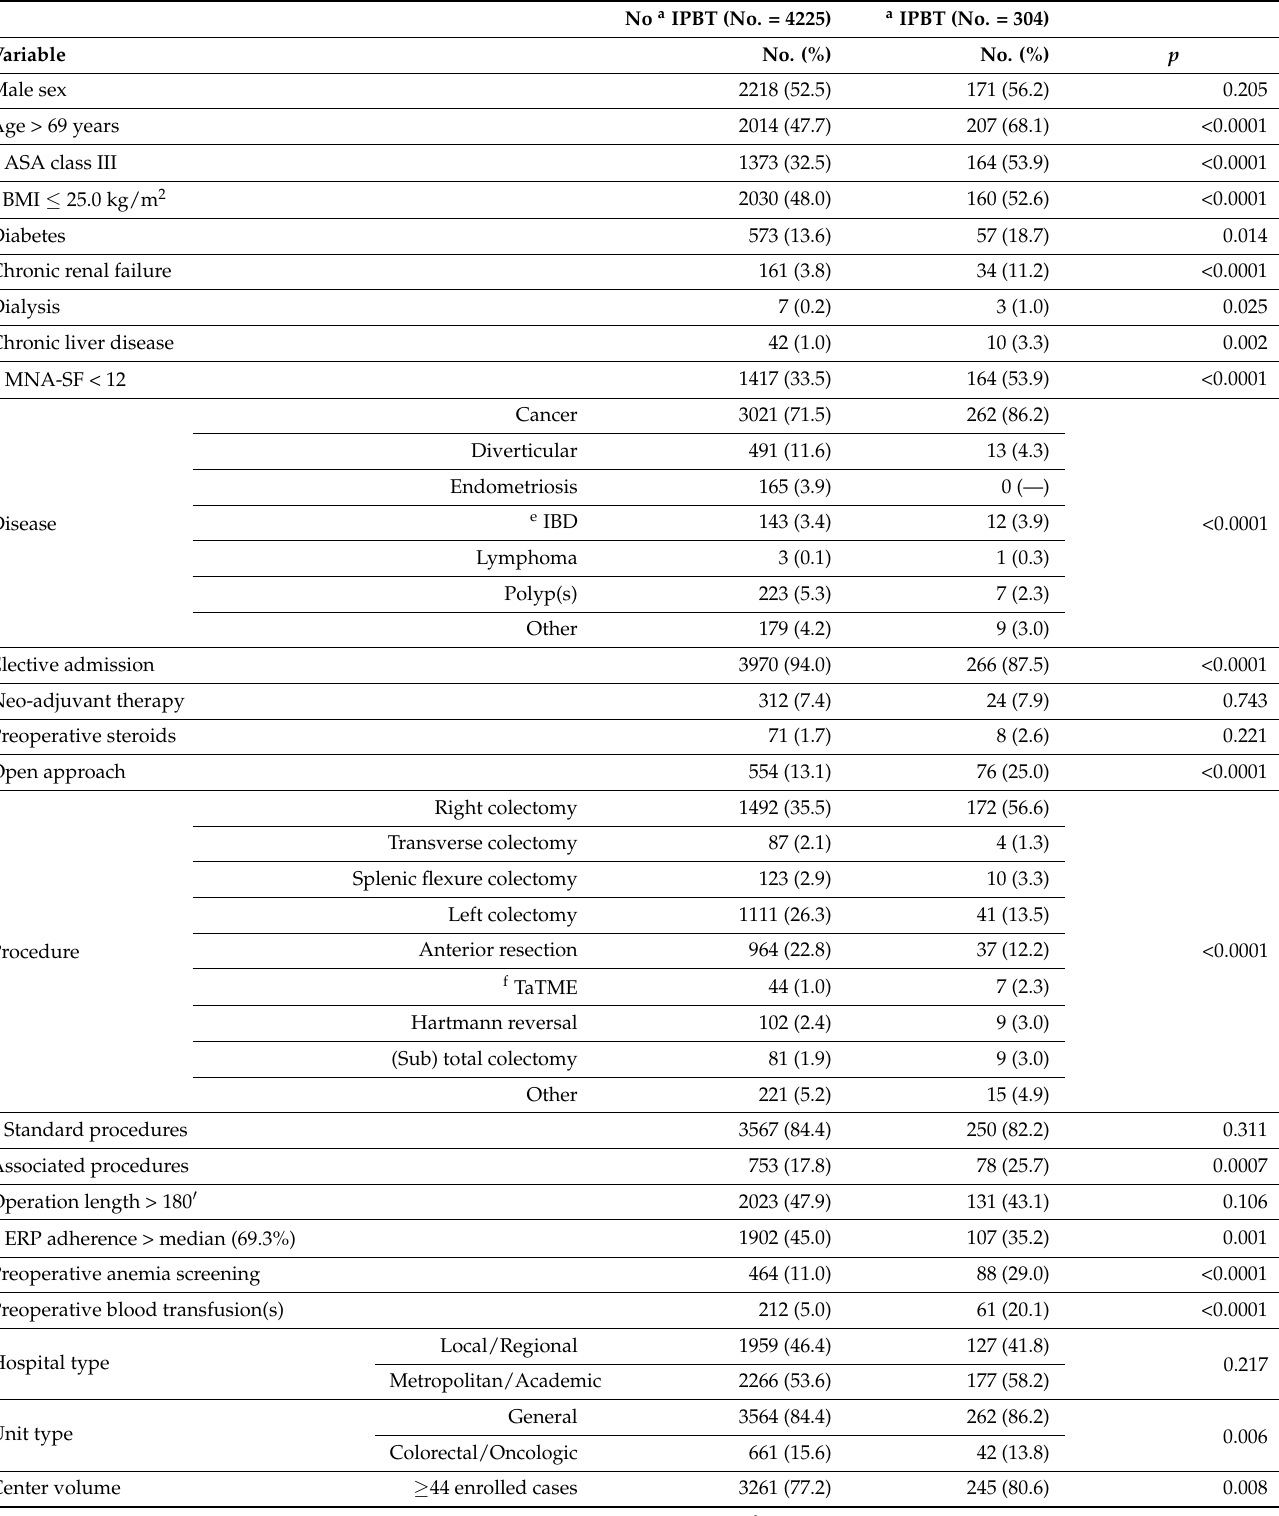
Table 1. Comparative analysis of study variables in the two